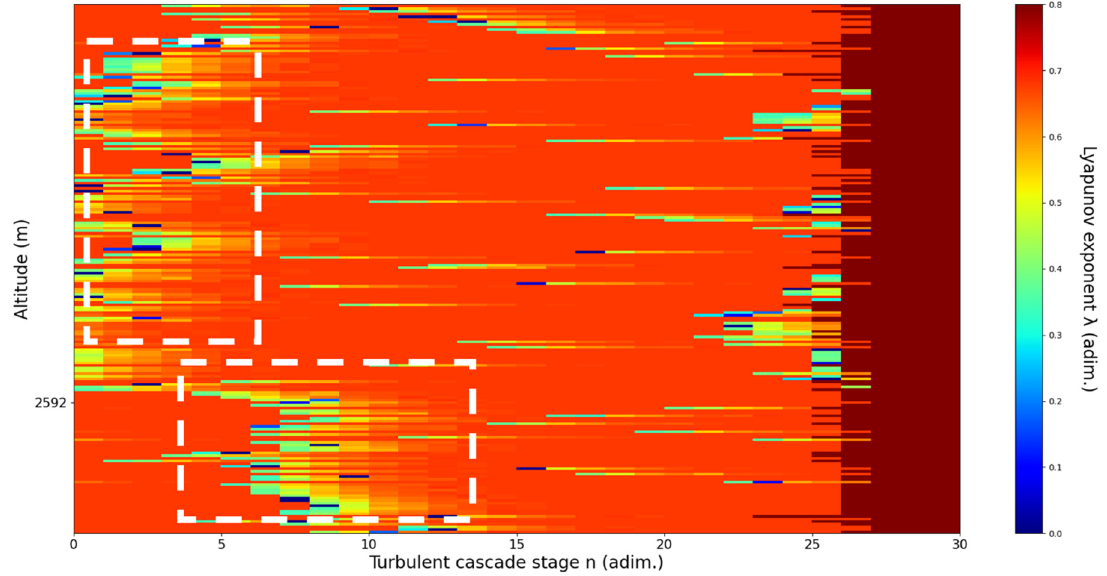
Figure 15. Lyapunov exponent per turbulent cascade stage colormap altitude plot, Bucharest, Romania, 13 June 2019, 07:10:00; point of interest: 2689 m.